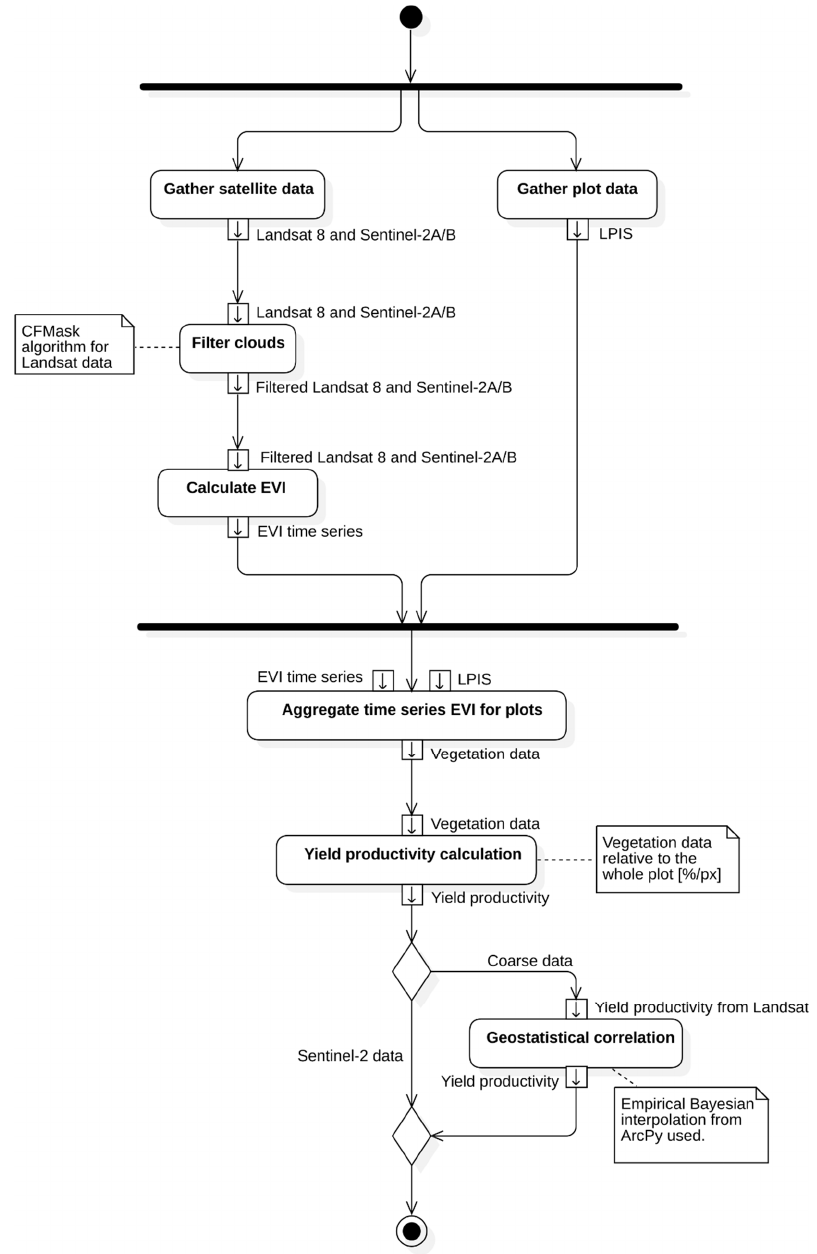
Figure 2. Schematic workflow of yield productivity zone identification and computation in the form of a Unified Modeling Language (UML) activity diagram.